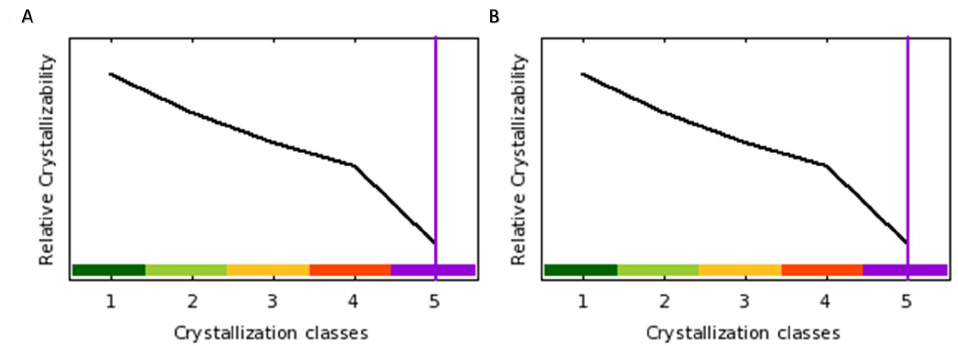
Figure 6. Protein crystalizability potential of ( A ) c-MYC and ( B ) USP37. Here, the x axis represents the increasing difficulty in crystallization and the vertical purple line represent the score of the molecule.